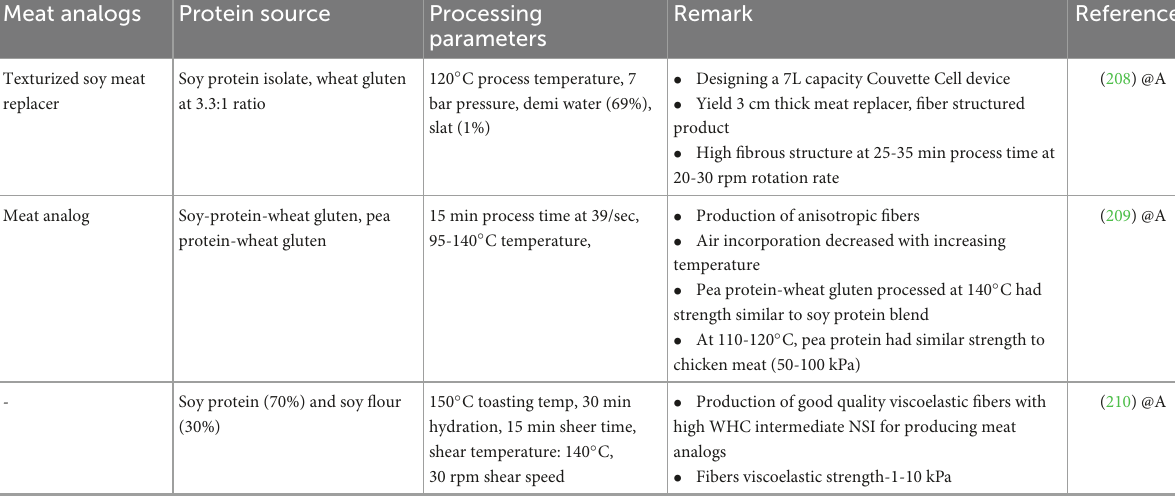
Couette cells (CC) are based on the concept of concentric cylinder rheometers and are used for texturing plant proteins by shear force. Krintiras et al. (208) scaled up the laboratory scale CC with a similar basic principle of viscous fluid